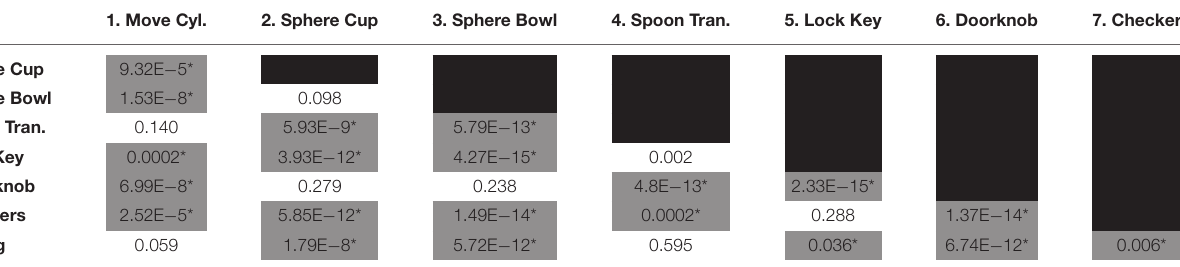
TABLE 7 | Statistical comparison of task attempt rate for all tasks in VR. 1. Move Cyl.